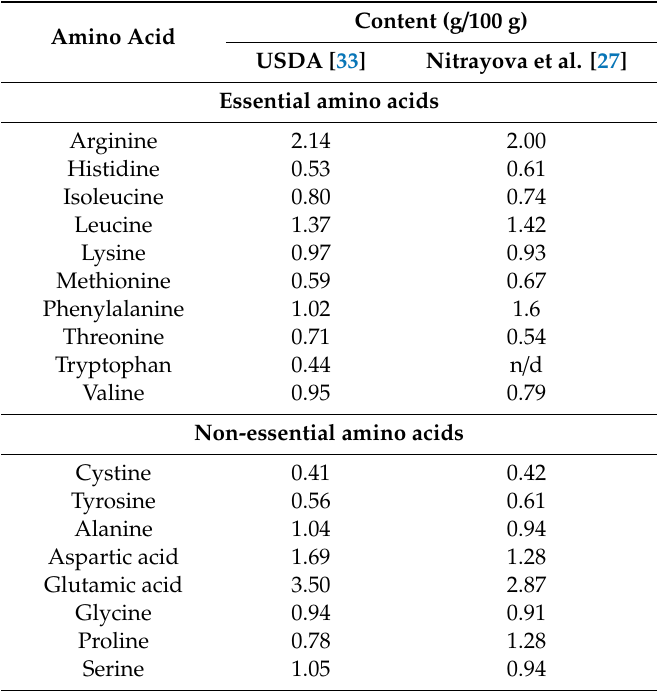
Table 3. Amino acid composition of proteins from chia seeds.